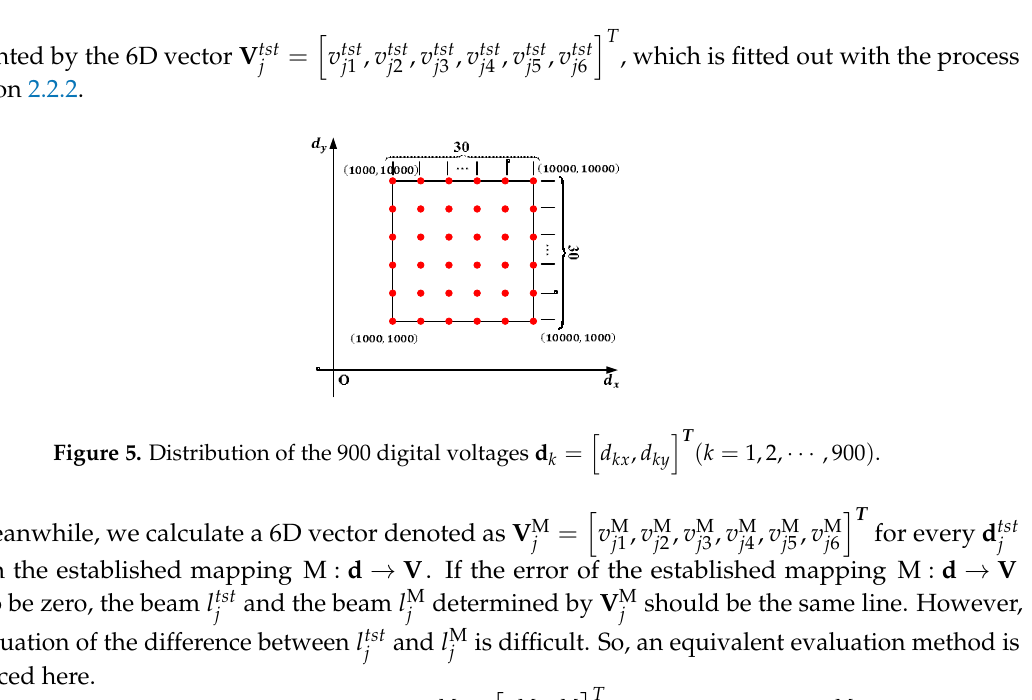
. Figure 5. Distribution of the 900 digital voltages d